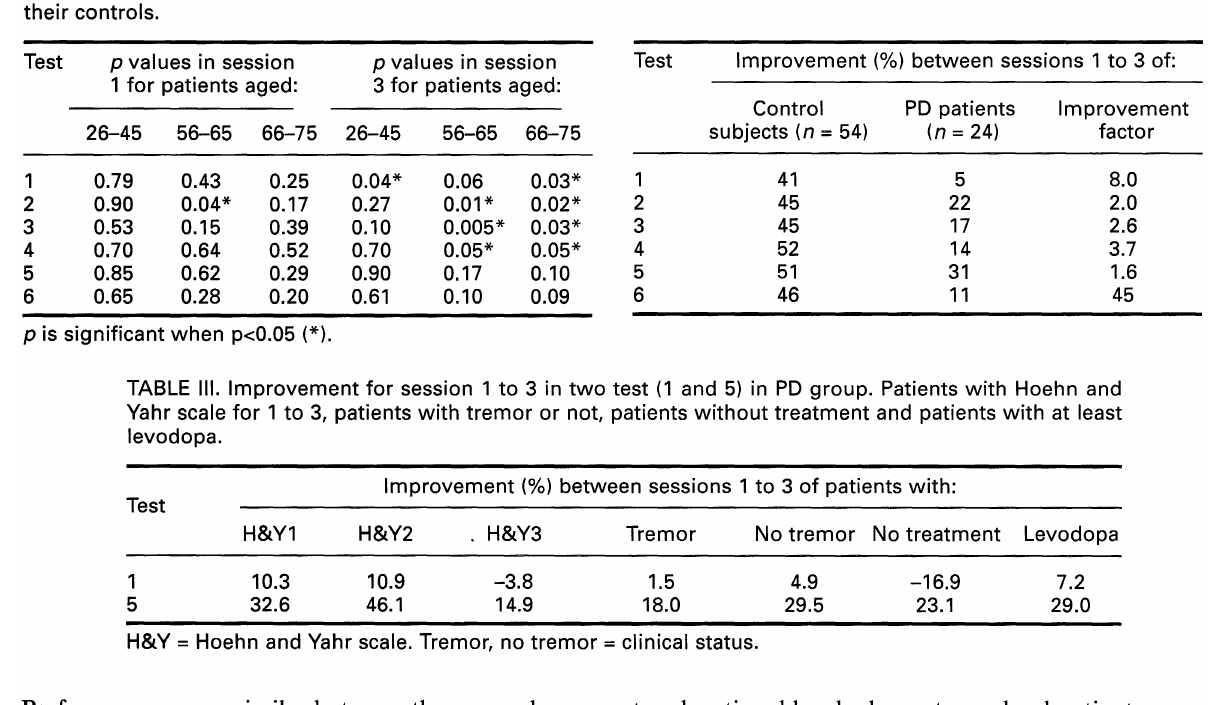
TABLE II. Improvement for session 1 to 3 in two groups: control group and PO group.